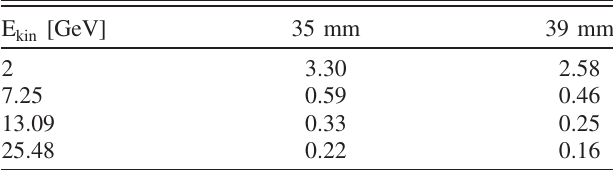
TABLE II. Imaginary part of the vertical effective impedance measured at different energies and zero chromaticity.